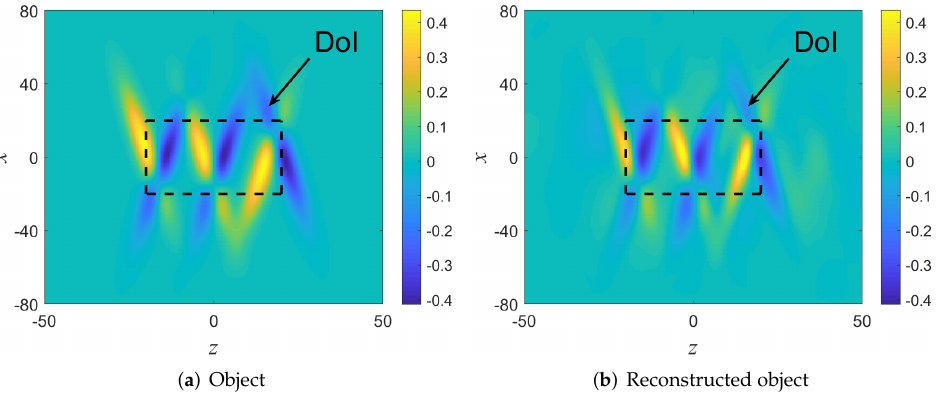
Figure 7. Example A: ( a ) The original ( a ) and the reconstructed ( b ) object functions. The DoI is illustrated by the black rectangle.